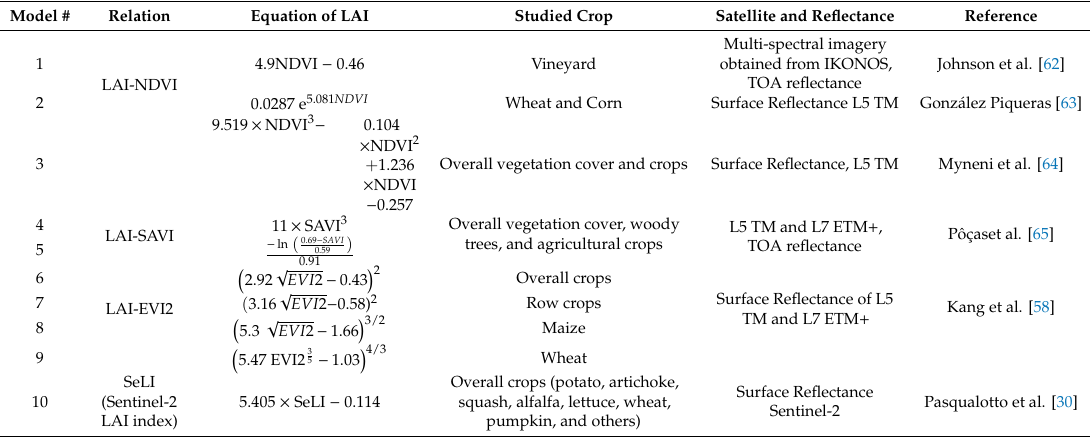
Table 3. A summary of the equations for the selected existing vegetation index-based LAI models evaluated in this study, along with the satellite and reflectance type used in the cited